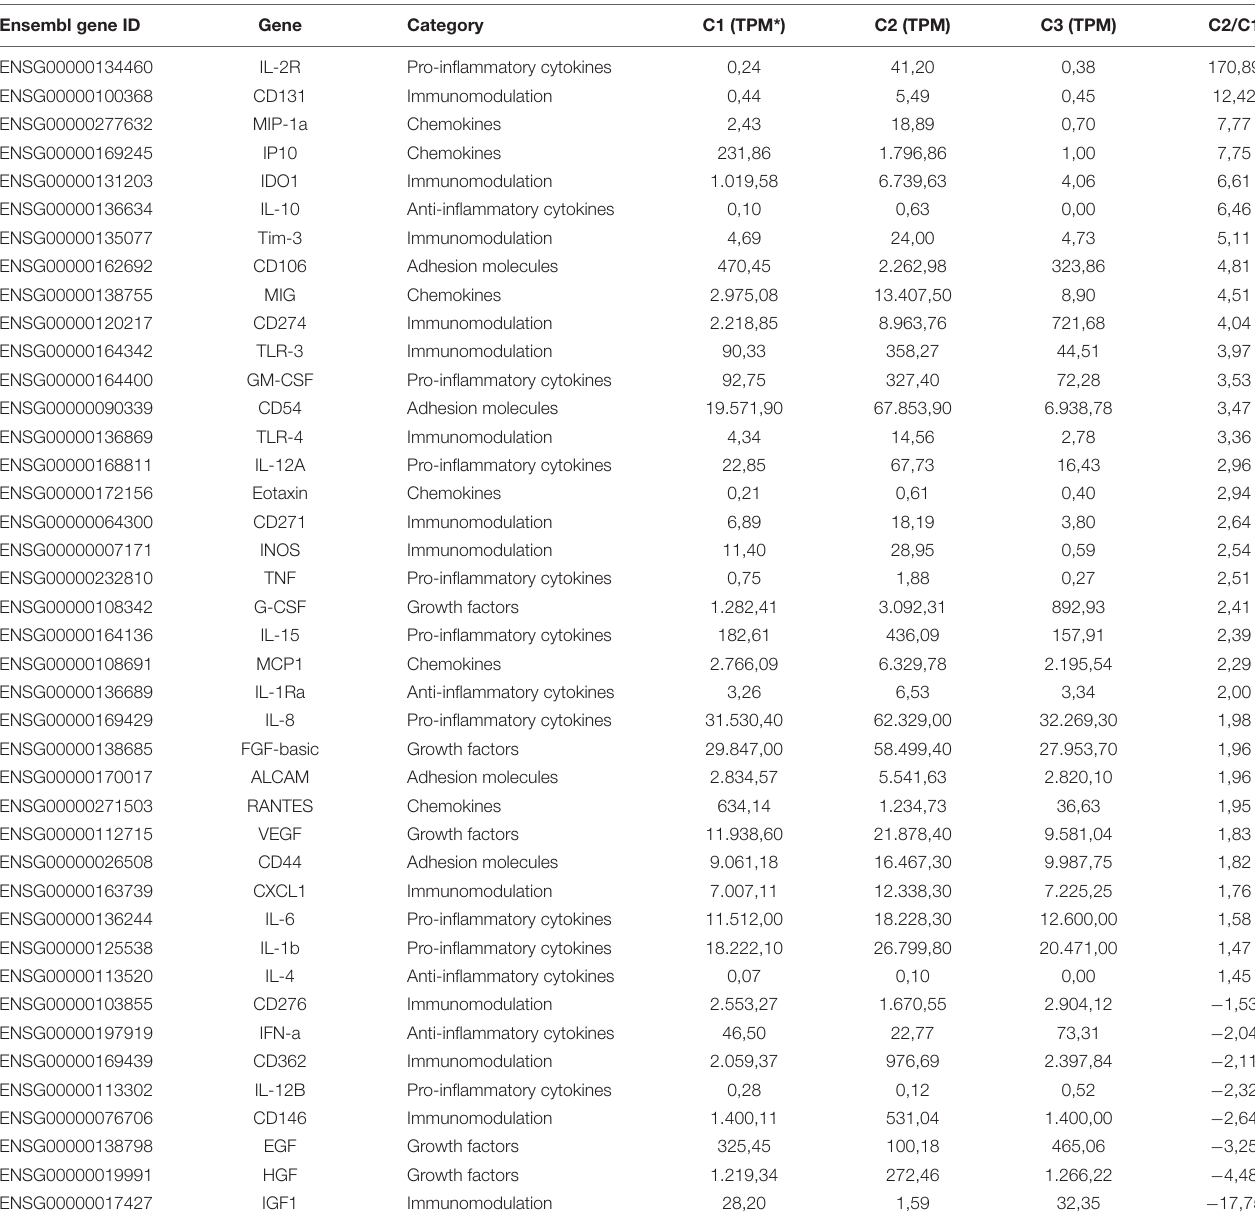
TABLE 1 | Selected DEG involved in immune modulation by